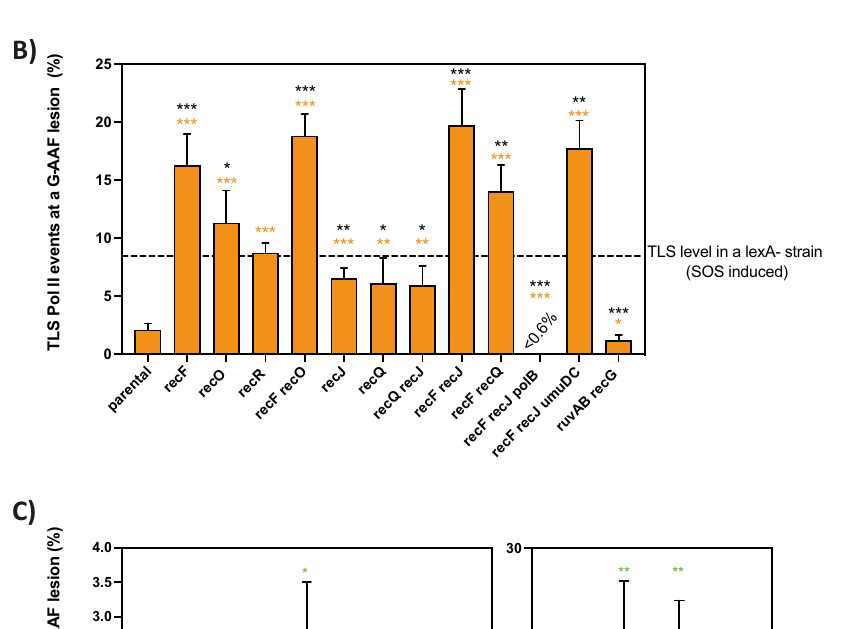
TLS level in a lexA- strain (SOS induced)